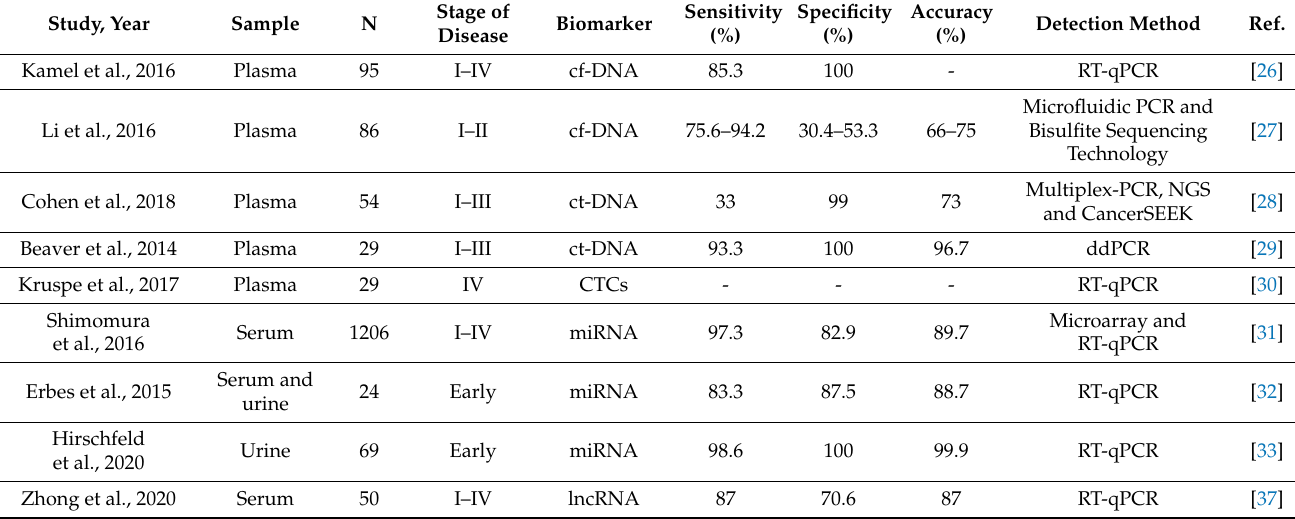
Table 1. Summary of potential non-invasive biomarkers using liquid biopsy for early detection of breast